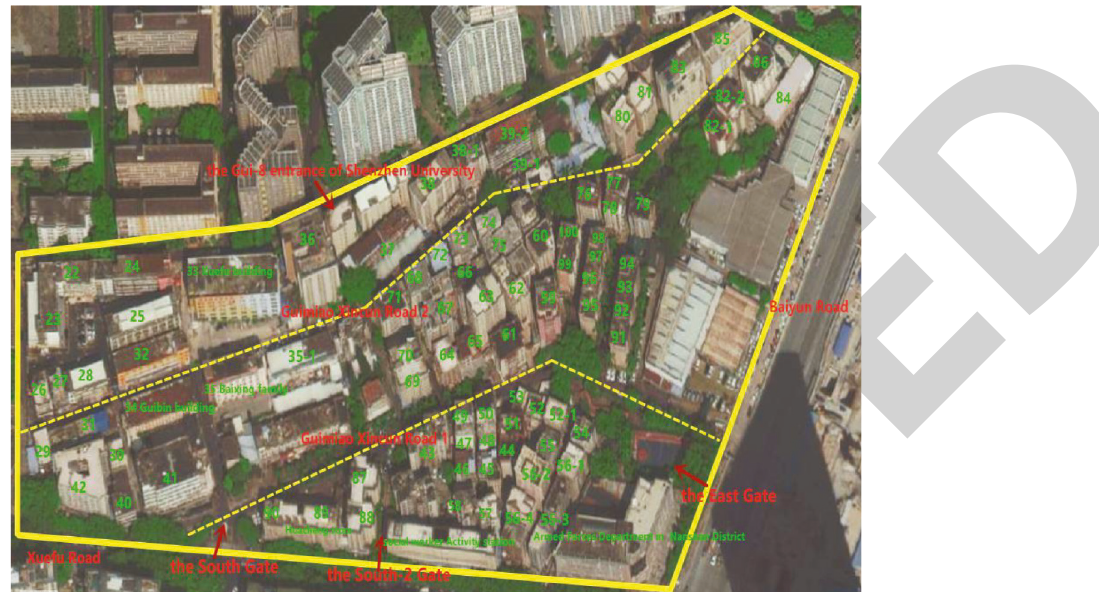
Figure 9: Electronic hand-drawn community map of a community in Shenzhen. Table 4: Effect after using community precise navigation map